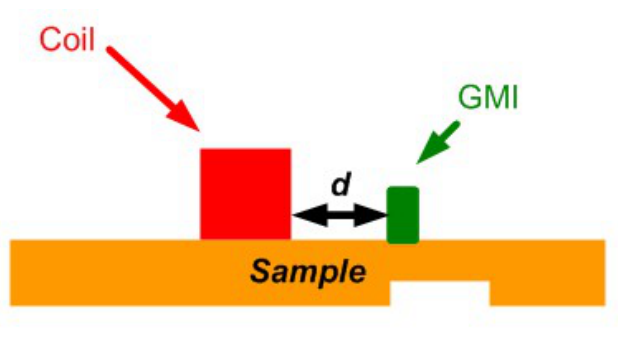
Figure 28. Schematic of the GMI based